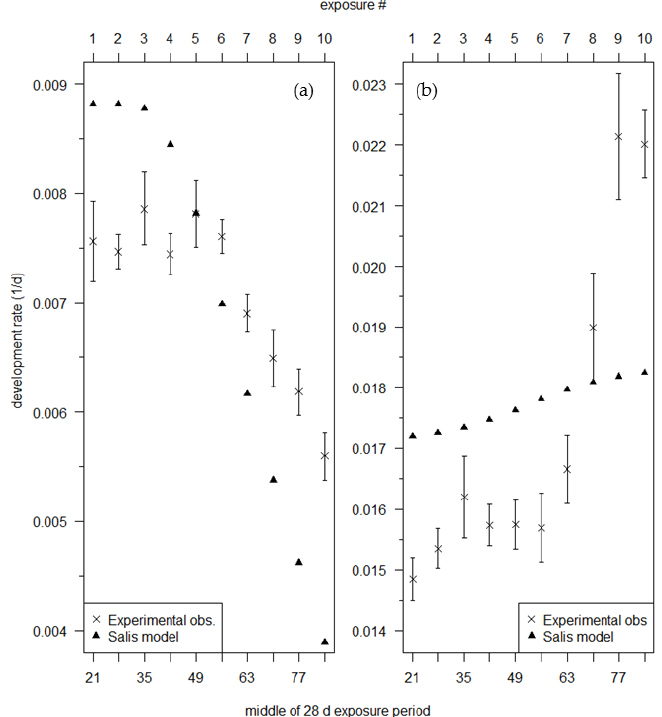
Figure 4. Age-dependent developmental rates during the 28 d exposures to ( a ) 5 °C and ( b ) 15 °C. A model rate ( ▲ ) is the mean of the 28 daily rates calculated from the Salis [10] model (Equation (8)). An experimentally observed rate (mean (×) and standard error) is estimated (Equation (9)) from the observed developmental durations of the 10 or 11 families per exposure period. #—number.